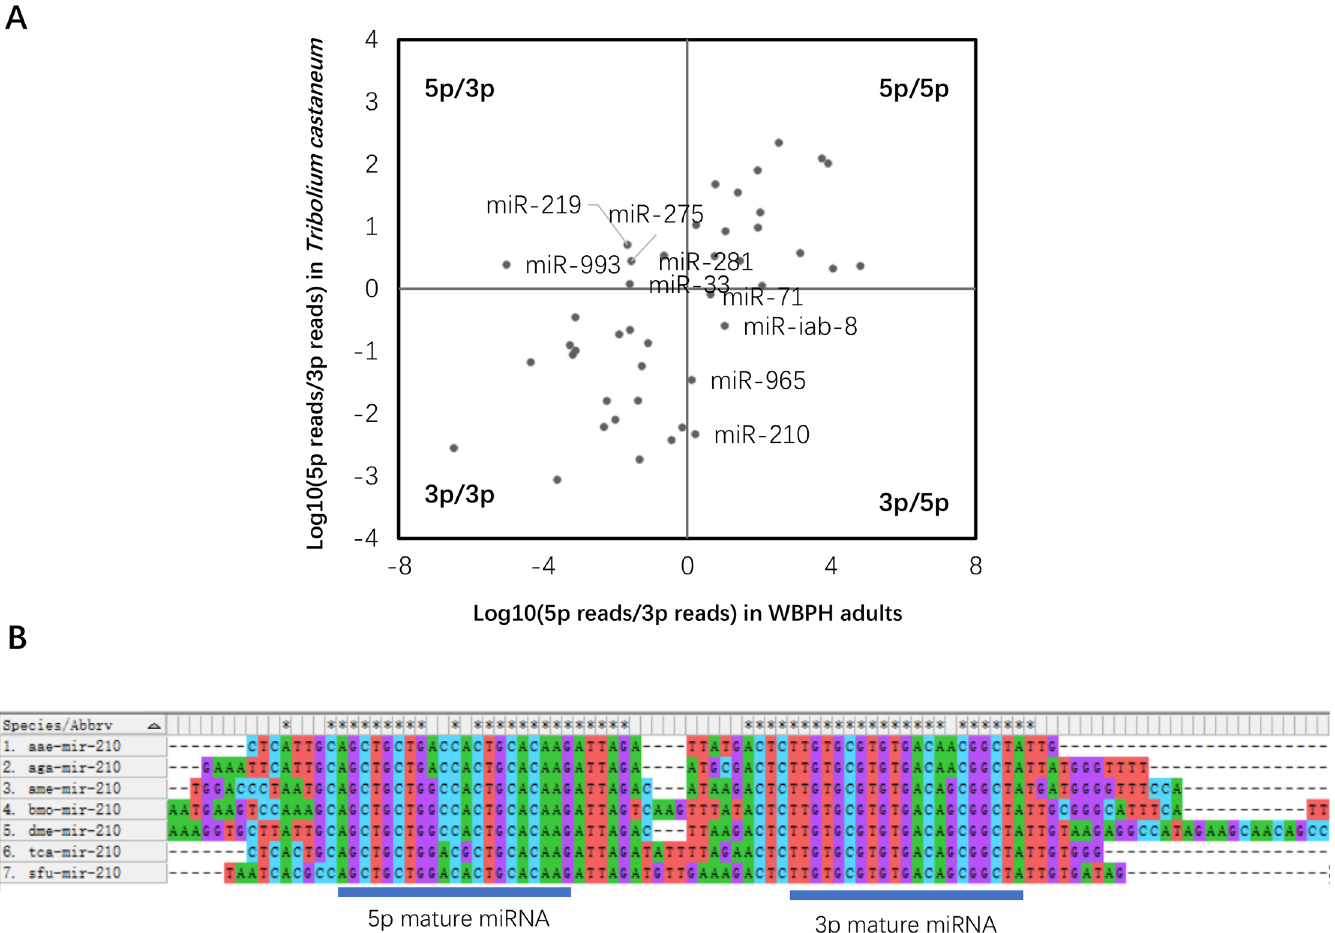
Fig 2. (A) Comparison of the arm usage bias between Tribolium and WBPH (B) conservation of miR-210 hairpin sequences in 7 insects. The abbreviation represents the species name. aae: Aedes aegypti; aga: Anopheles gambiae; ame: Apis mellifera;bmo: Bombyx mori; dme: Drosophila melanogaster tca: Tribolium castaneum.